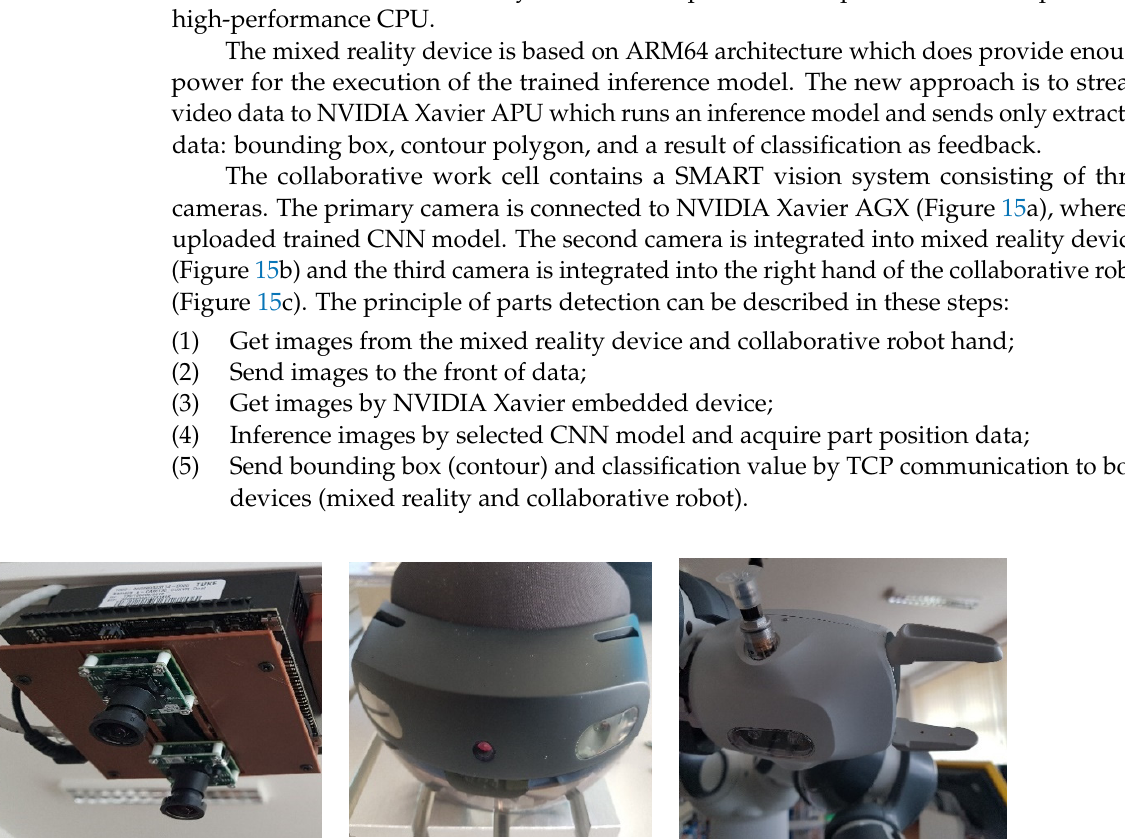
Figure 16. The principle of an experimental assisted assembly work cell with CNN processing unit, mixed reality device, and collaborative robot. Images captured by all vision systems (static dual 4K e-con cameras connected to NVIDIA Xavier AGX and JetPack 4.4, integrated Cognex 7200 camera in ABB Yumi right hand and Microsoft Hololens 2 internal head camera) are shown in Figure 17.